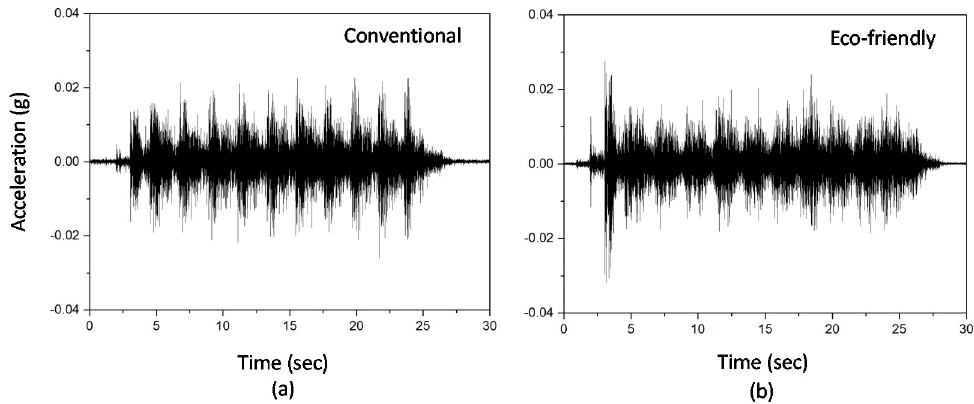
Figure 18. Time history graph of the vertical acceleration recorded on the B2S panels: (a) Conventional B2S and (b) Eco-friendly B2S.